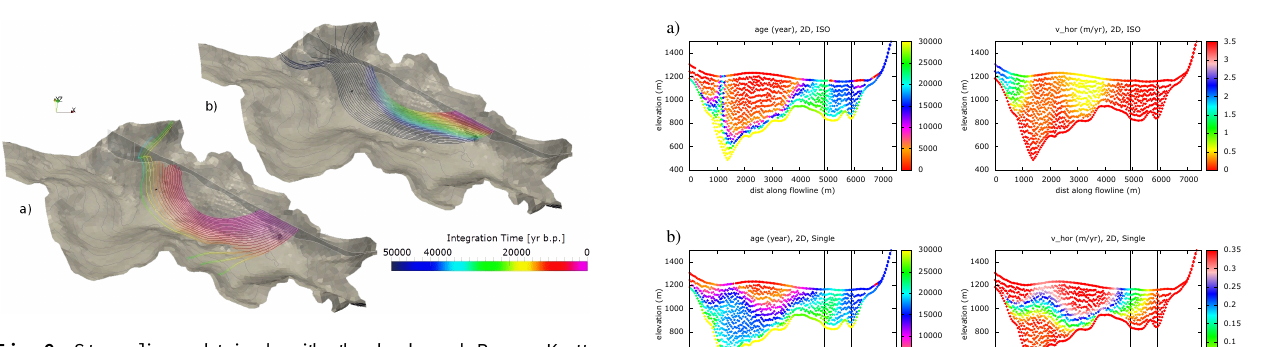
Fig. 9. Streamlines obtained with the backward Runge–Kutta method implemented in ParaView starting from the area where the ice cores have been sampled, colored by integration time given in years for (a) isotropic and (b) single maximum fabric distribution. The depth-dependent anisotropic fabric (not shown) is almost the same as the isotropic case and is characterized by stream lines orig- inating in the area between the inner and the outer BIA and at the southern flanks. In contrast, the single maximum fabric shifts the origin of the stream lines towards the outer parts of the valley and significantly increases the travel time of the fluid particles.